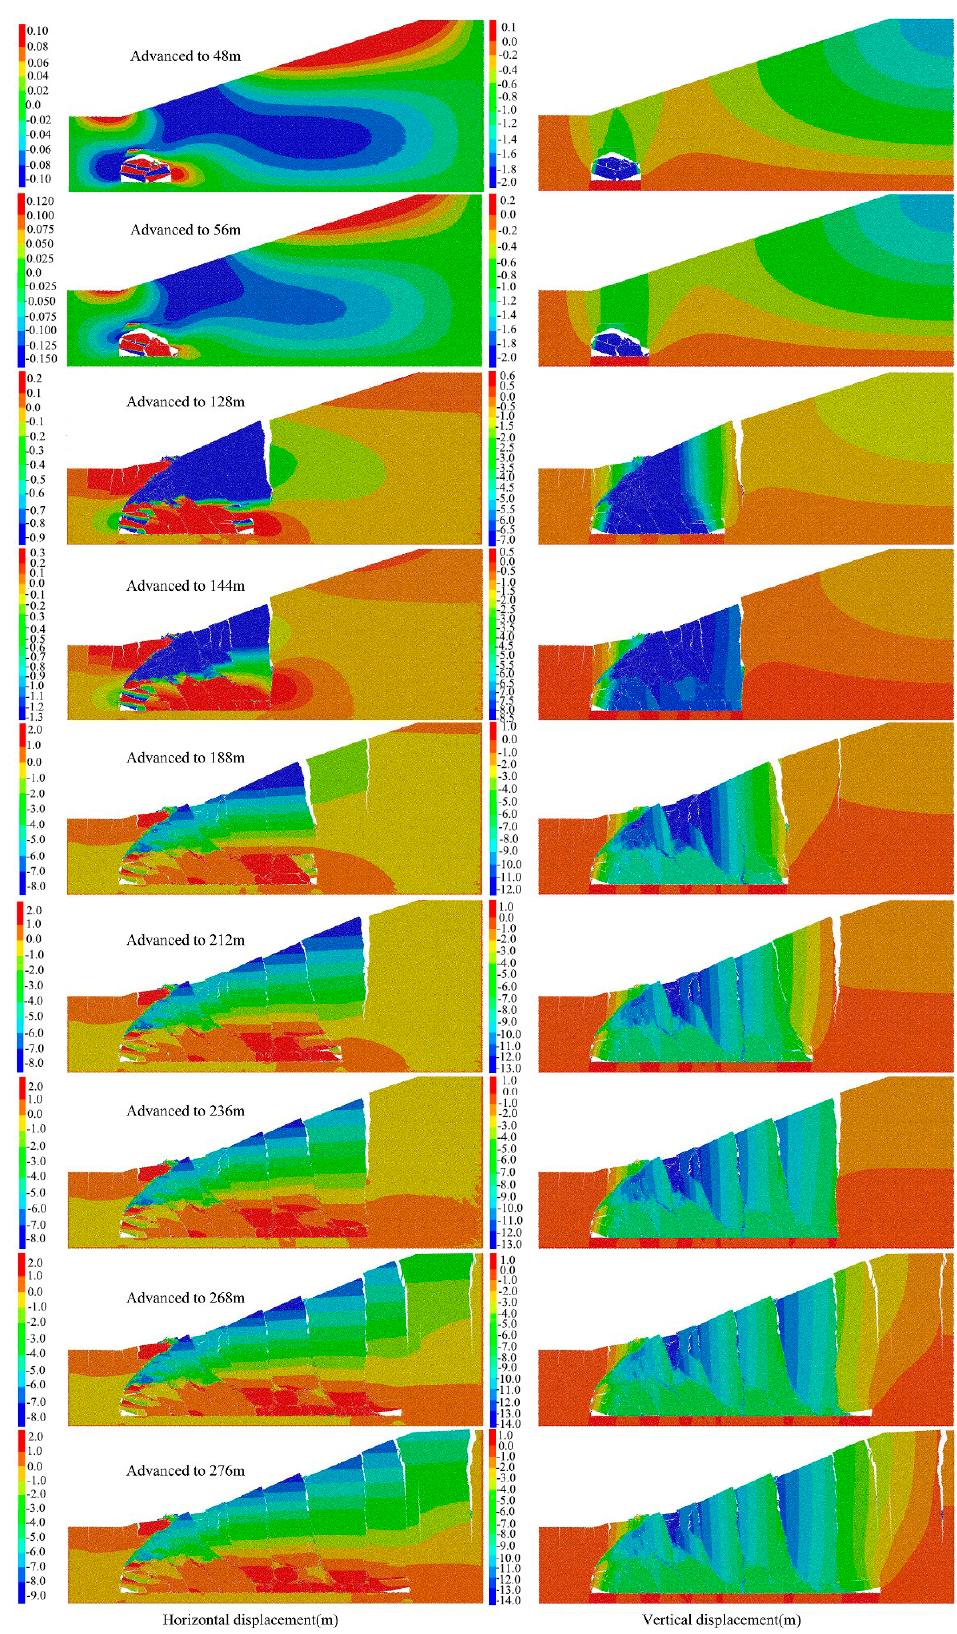
Figure 20. Horizontal and vertical displacements caused by